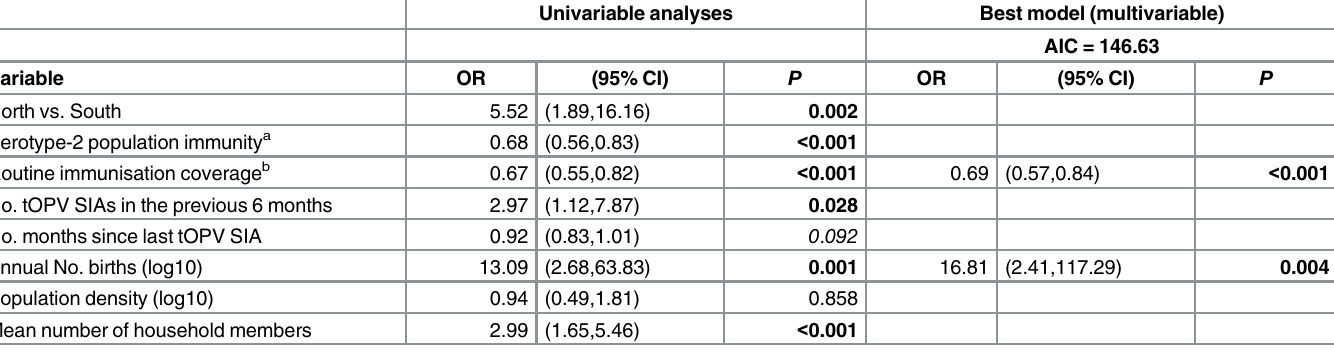
Table 1. Univariable and multivariable analyses of cases (district − 6-months where the first AFP case associated with a VDPV2 emergence was detected) vs. controls (district − 6-months with no VDPV2 emergence). Abbreviations: CI, confidence interval; OR, odds ratio; P , p-value. Statistically sig- nificant p-values < 0.05 are shown in boldface. Borderline significant p-values < 0.1 are shown in italics.